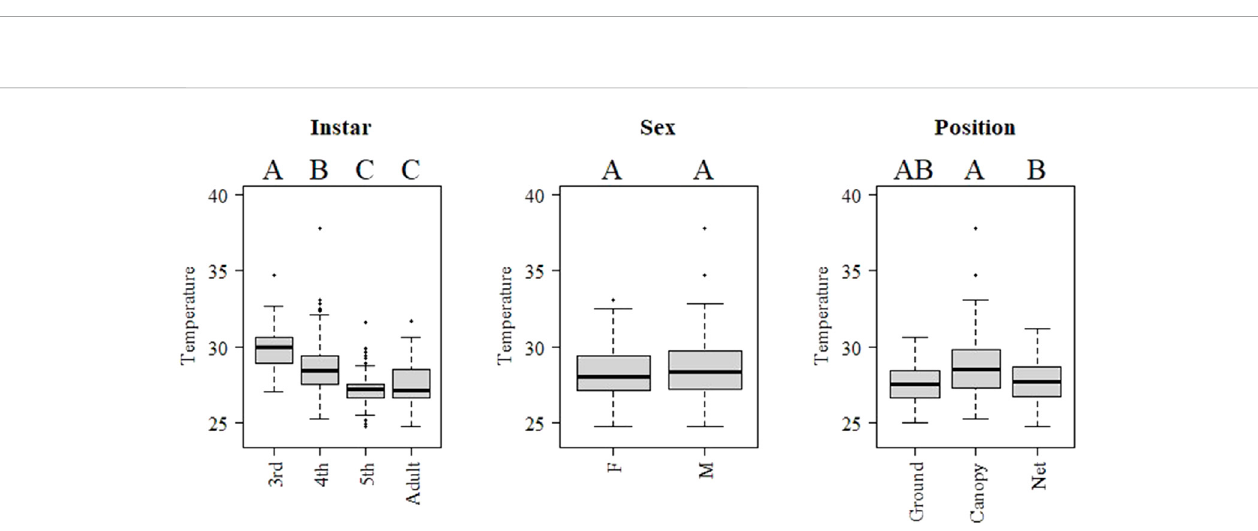
FIGURE 7 Boxplotsofinternalbodytemperatureof Locustamigratoriamanilensis ,instar,sexandpositionatnight-time(rawdata19:00 – 05:59).Lettersaboveeach level indicate signi fi cant differences ( p < 0.05) between levels in a mixed model including all indicated factors and controlling by hour.